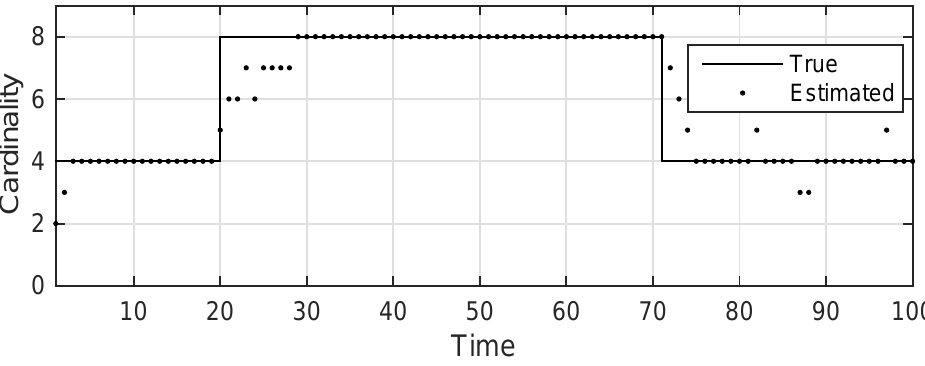
Figure 10. The estimated number of targets by GLMB filter.